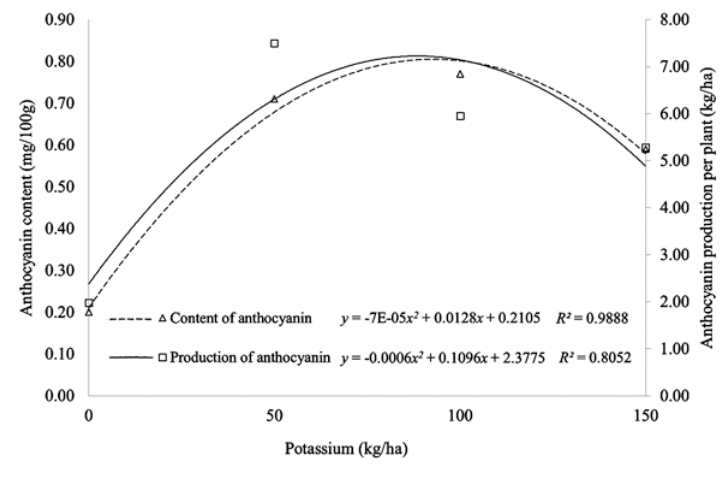
Figure 1 Effect of potassium on anthocyanin content (mg/100 g fresh weight) and tuber production (kg/ha) at the highland